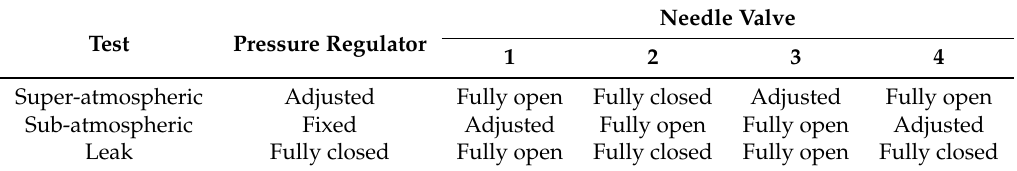
Figure 1. The laboratory pressure test setup of the Axetris LGD F200-A NH 3 for measuring gases from cylinders under different inlet-pressures. Table 1. Valve positions in the laboratory pressure test setup using a gas